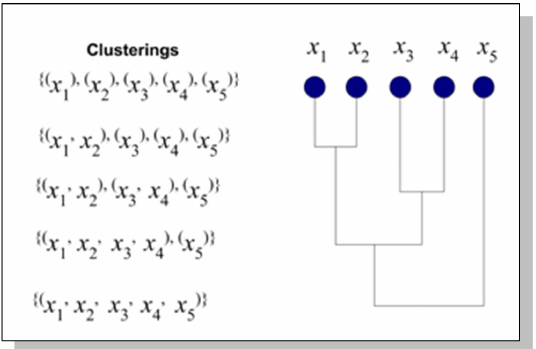
Figure 2: Example of a hierarchical clustering on the left side and its dendrogram on the